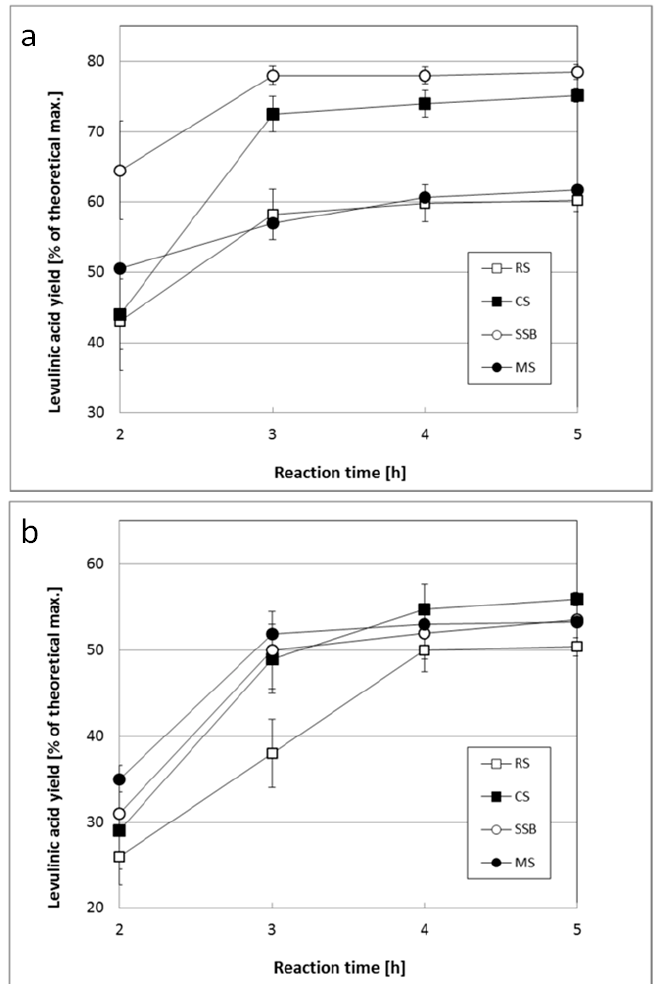
Figure 4. Variation of the yield of LA as a function of reaction time from ( a ) untreated and ( b ) green liquor pretreated biomass (rice straw, RS; corn stover (CS); sweet sorghum bagasse (SSB) and miscanthus (MS) [Reaction conditions: 1 M HCl, 150 °C, 50 g/L solid loading; biomass particle size > 2000 µm]. Adapted with permission from MDPI [63].